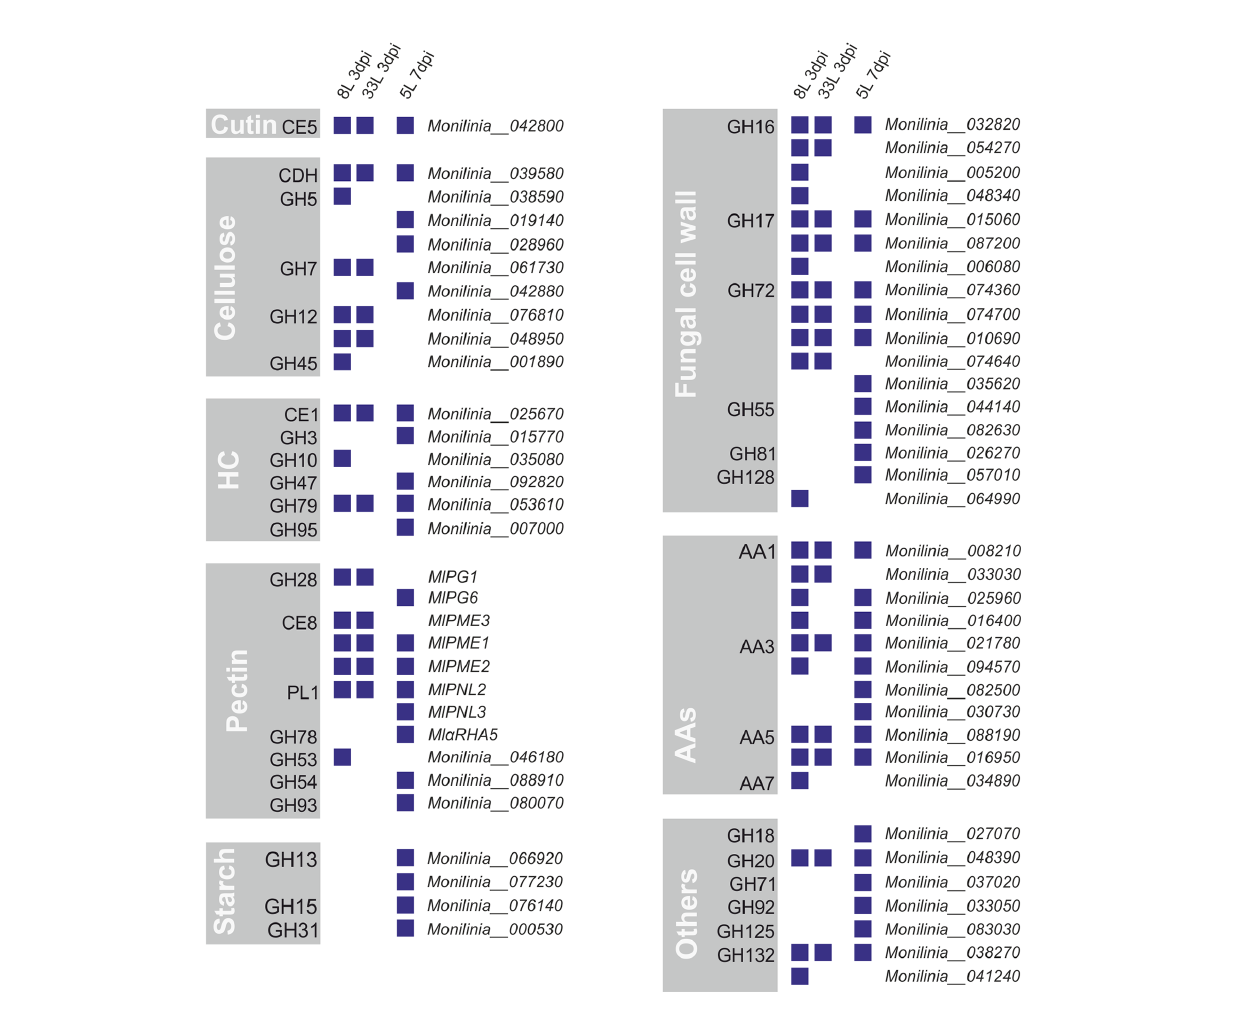
FIGURE 4 | CAZymes identi fi ed from exoproteomes of virulent M. laxa isolates 8L and 33L at 3 dpi, and weak virulent 5L at 7 dpi. Each group depicts a plant cell wall target, including auxiliary activities (AAs), CAZymes related to the fungal cell wall and a miscellaneous group indicated as others. Positive identi fi cation of a protein in each isolate proteome is presented as a blue square. On the right is indicated the corresponding protein unique identi fi cation